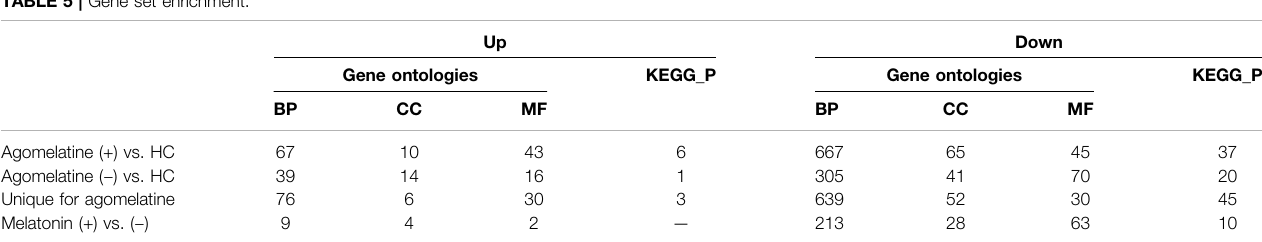
TABLE 5 | Gene set enrichment. Up Down Gene ontologies KEGG_P Gene ontologies KEGG_P BP CC MF BP CC